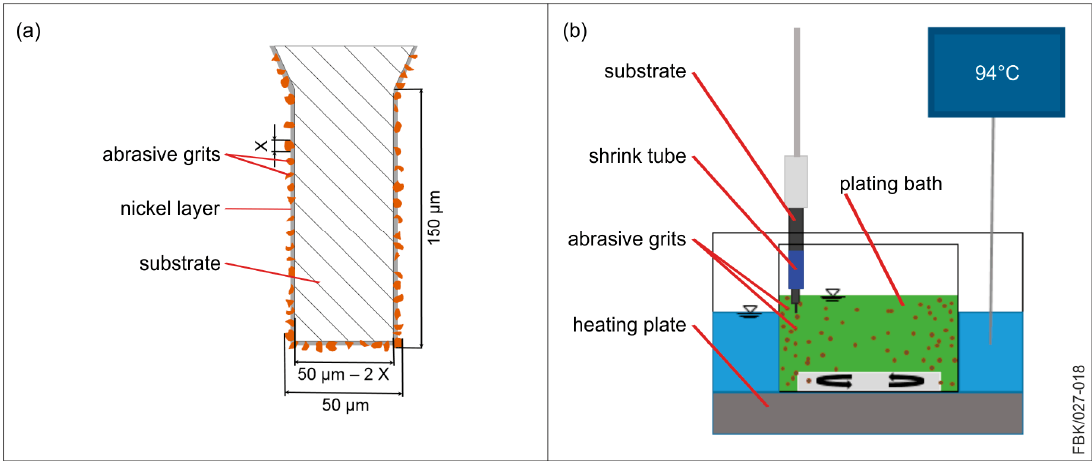
Figure 4. ( a ) Schematic of electroless plated MPGT tip; ( b ) schematic of electroless plating setup.